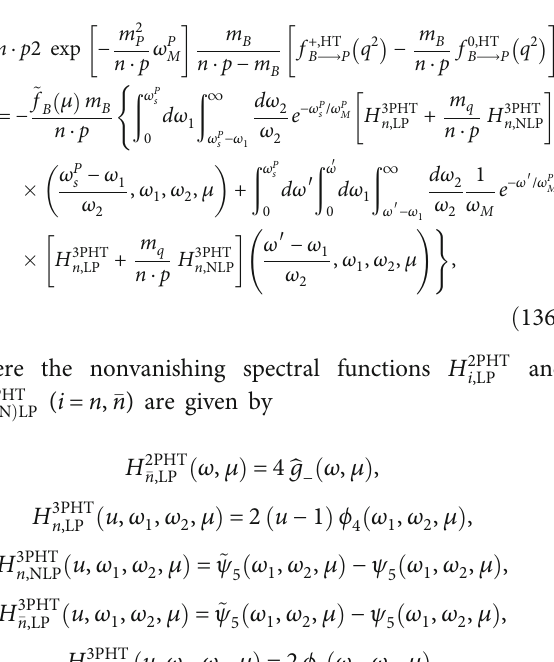
Figure 6: Diagrammatical representation of the three-particle higher-twist corrections to the vacuum-to- B -meson correlation function. The square box indicates the insertion of the weak vertex (cid:1) q Γ μ b , and the waveline represents the interpolating (cid:1) current dn γ q for the light-pseudoscalar 5